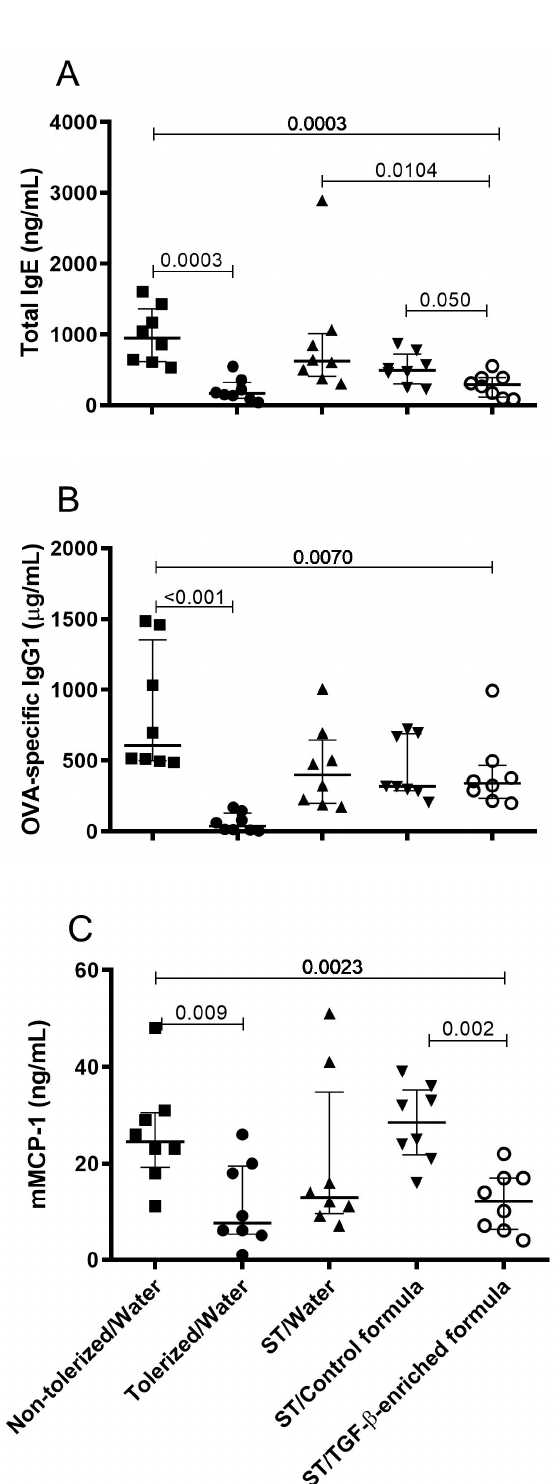
Figure 4. E ff ect of the oral supplementation of mice with a TGF- β -enriched formula on the protection against sensitization and response to oral exposure to OVA. ( A ) Total IgE, ( B ) OVA-specific IgG1, and ( C ) mMCP1 levels in plasma in 5-week-old mice subjected to a food allergy protocol. Mice received PBS using a gavage on days 6, 7, and 8 (non-tolerized / water), OVA (10 mg / mL) ad libitum from day 4 to day 8 (tolerized / water), or a sub-tolerogenic dose of OVA (0.5 mg) using a gavage on days 6, 7, and 8 (ST / water). ST / water mice had free access to either water, control formula, or TGF- β -enriched formula from day 1 to day 13. Values are expressed as the median ± interquartile range of eight mice per group. Significant p -values ( ≤ 0.05) are shown on the